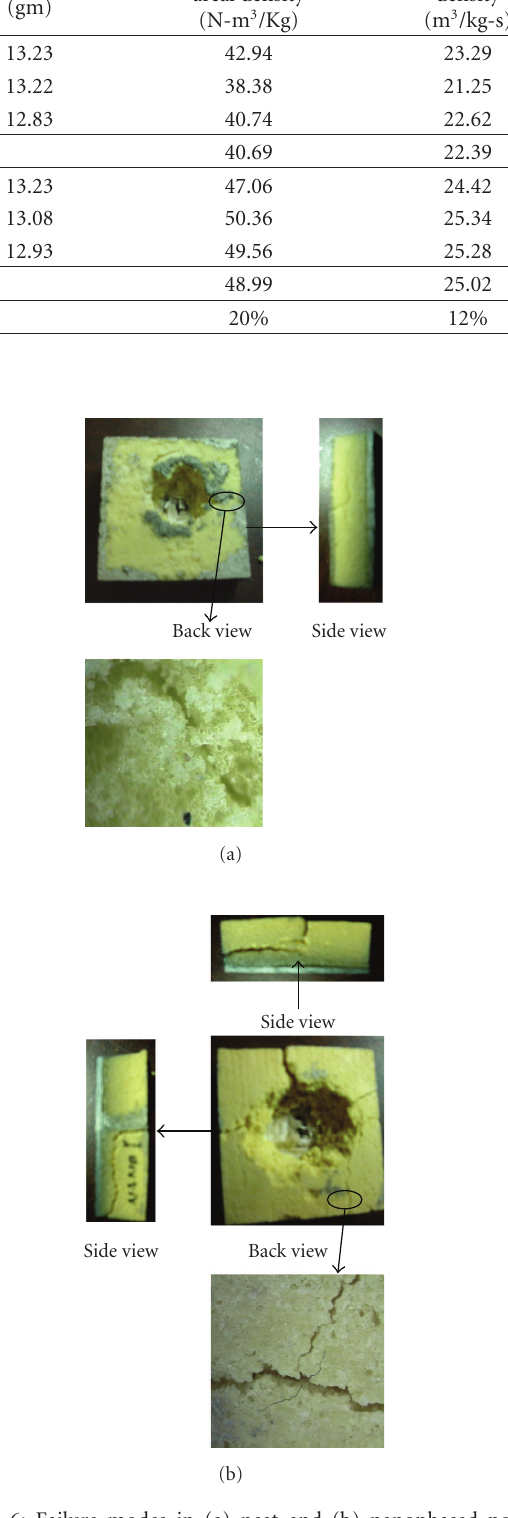
Figure 6: Failure modes in (a) neat and (b) nanophased poly- urethane